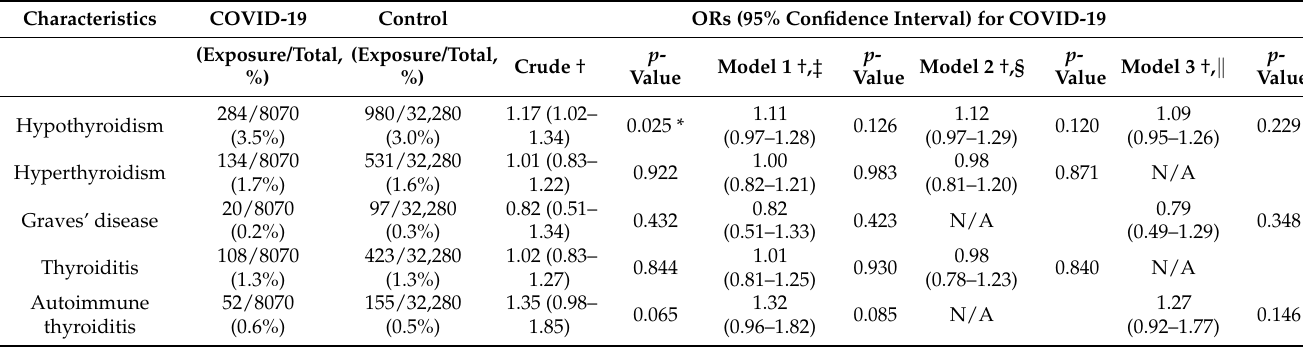
Table 2. Odds ratios of each thyroid disease for COVID-19 infection in all